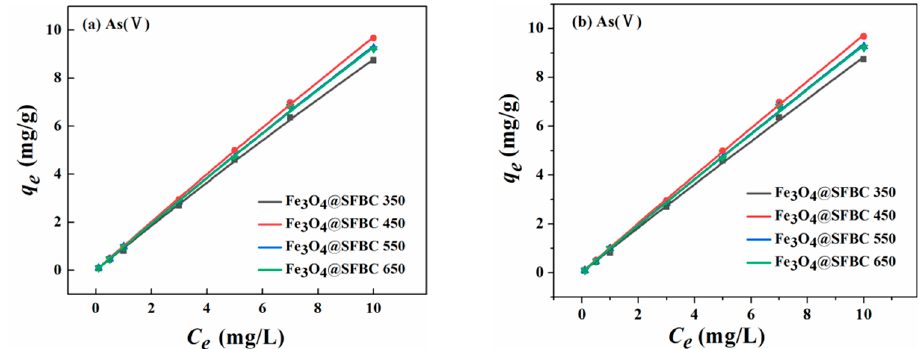
Figure 6. Adsorption isotherms of Langmuir ( a ) and Freundlich ( b ) on As(III) by Fe 3 O 4 @SFBC (prepared from biochar at different calcination temperatures) (experimental conditions: pH = 6, dose = 1 g/L, initial concentration = 0.1–10 mg/L, T = 25 °C).